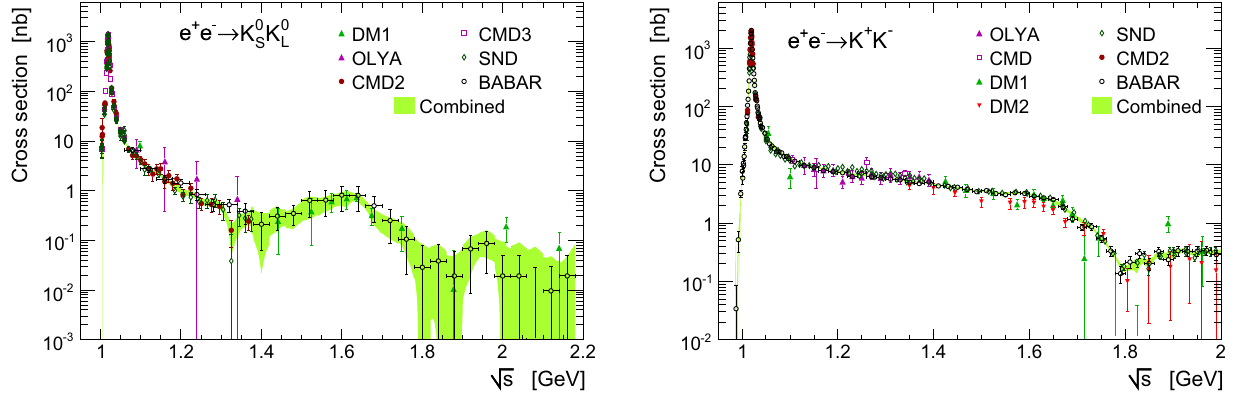
Fig. 6 Bare cross sections for e + e − → K 0